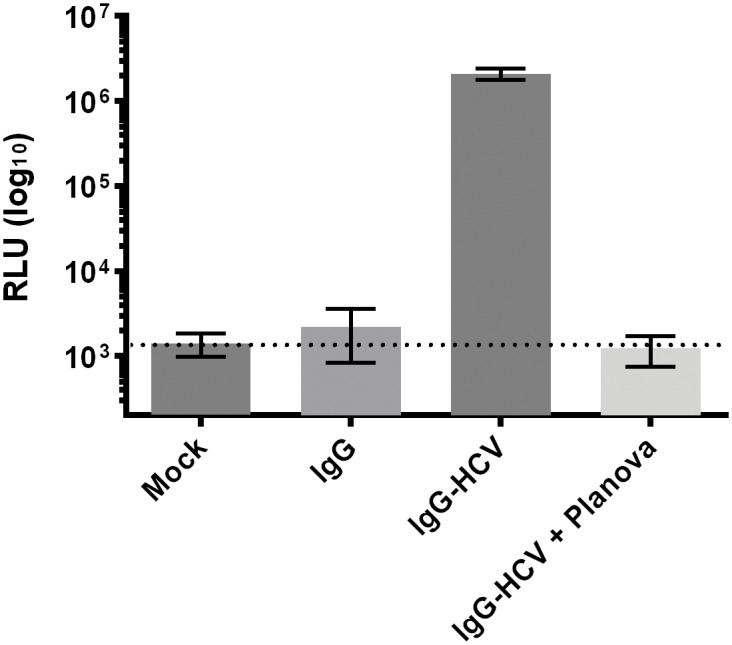
Removal of the hepatitis C virus (HCV) during nanofiltration as determined using luciferase reporter measurements (log10 RLU).N = 3. Mean ± SEM. The dashed line indicates the background level of luciferase activity.